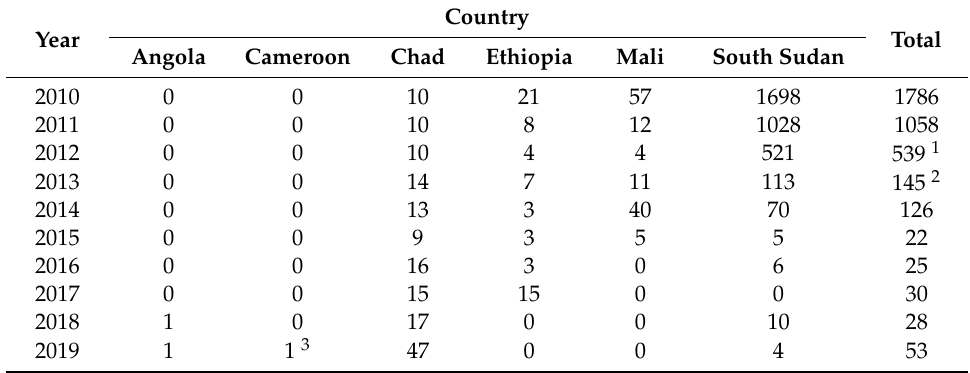
Table 1. Reported Human Cases of Guinea Worm Disease in Considered Countries,